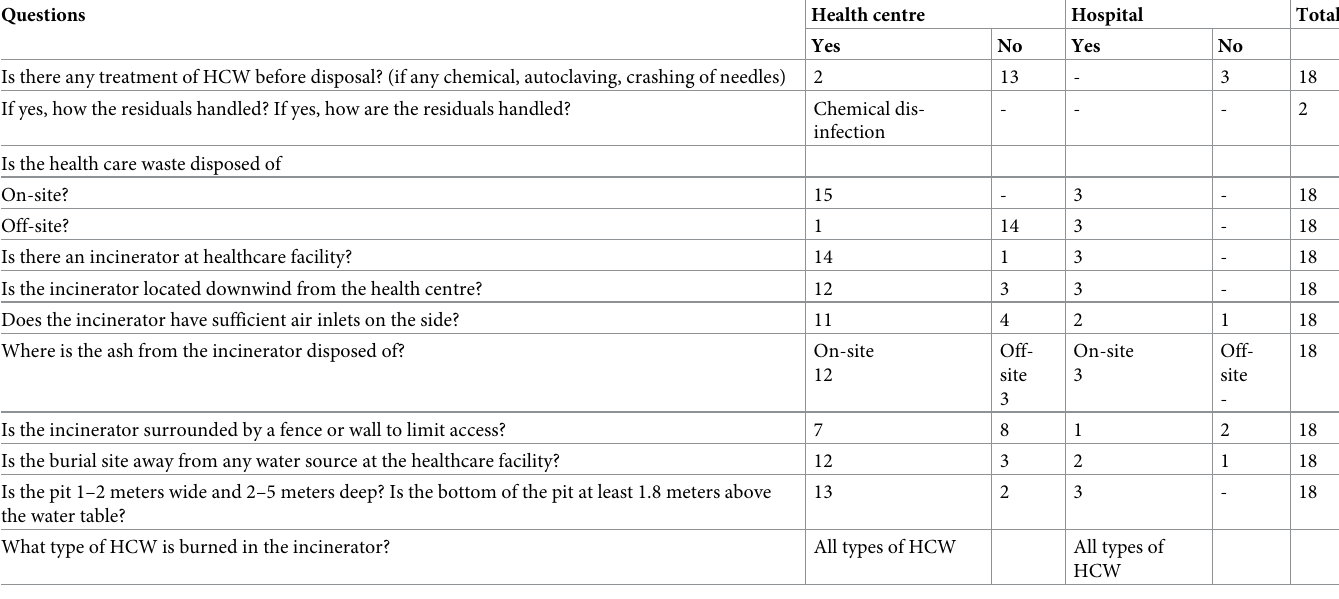
Table 15. Observed treatment and disposal of HCW in the study health facilities, Addis Ababa City Administration, February